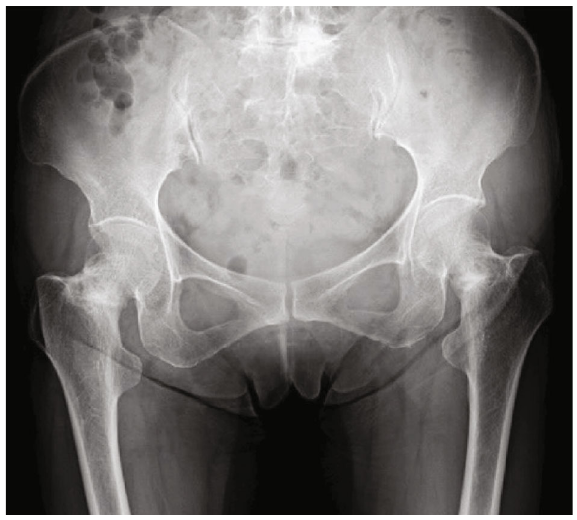
Figure 1: Preoperative radiograph of the present case demonstrating bilateral femoral neck stress fracture with